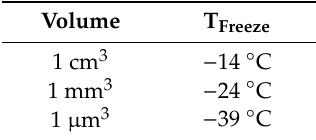
Table 5. Correlation between water domain size and freezing temperature